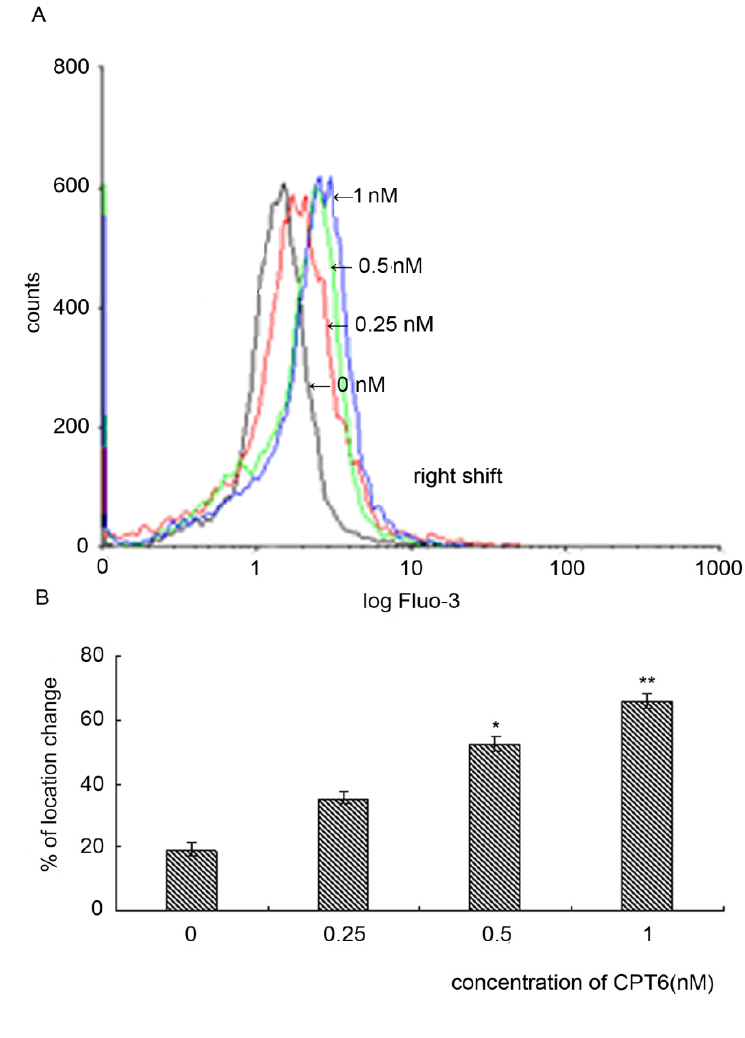
Figure 8. Changes in intracellular calcium in MCF-7 cells treated with CPT6 for 48h. A : Black line represents control group; red line represents cells treated with 0.25 nM CPT6; green line represents cells treated with 0.5 nM CPT6; blue line represents cells treated with 1 nM CPT6 (excitation: 488 nm; emission: 525 nm). B : Change in calcium levels in MCF-7 cells. The results were reproducible in three additional independent experiments (* p < 0.05, ** p < 0.01); p value compared with the control group (0